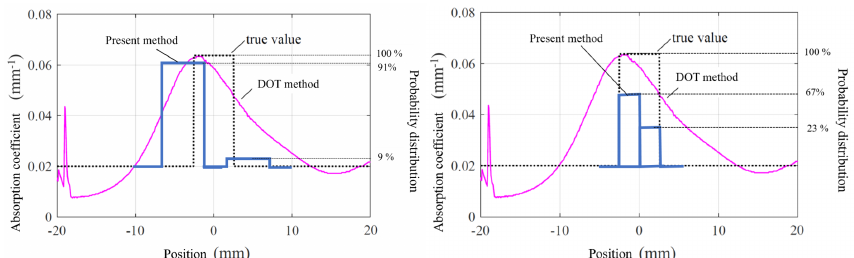
Figure 12. Comparison of the present method with the conventional DOT method. The true absorp- tion coefficient is shown by the dotted line. The pink curve depicts the reconstructed coefficient using the conventional DOT method. The blue line represents the probability distributions of the absorption coefficients predicted by our deep learning method, where the setup is the same as Figure 1. The left ( right ) panel is used by resolution as 28 domains (168